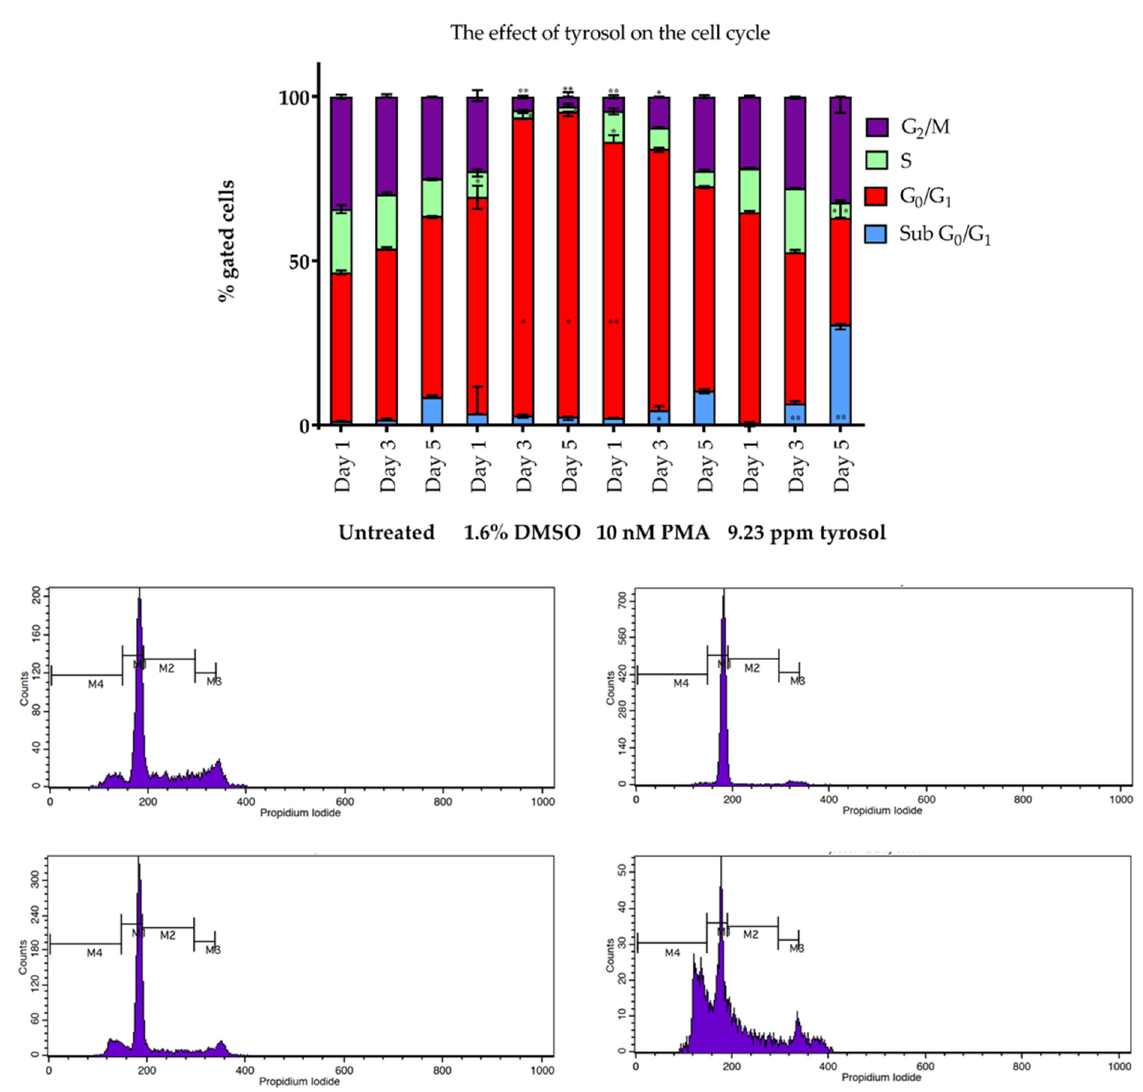
Figure 6. Percentage gated HL-60 cells in the Sub G 0 /G 1 , G 0 /G 1 , S, and G 2 /M phases of the cell cycle on day 1, day 3, and day 5 and representative histograms for each condition on day 5. Histograms from left to right = Untreated, 1.6% DMSO, 10 nM PMA, and 9.23 ppm tyrosol. Untreated = negative (medium only) control, 1.6% DMSO, 10 nM PMA are positive controls for granulocytic and monocytic differentiation, respectively. Each bar represents the median value where n = 4. Error bars represent differences between the median and upper and lower quartiles. Statistically significant differences from the negative control are denoted by (*) p < 0.05 and (**) p <